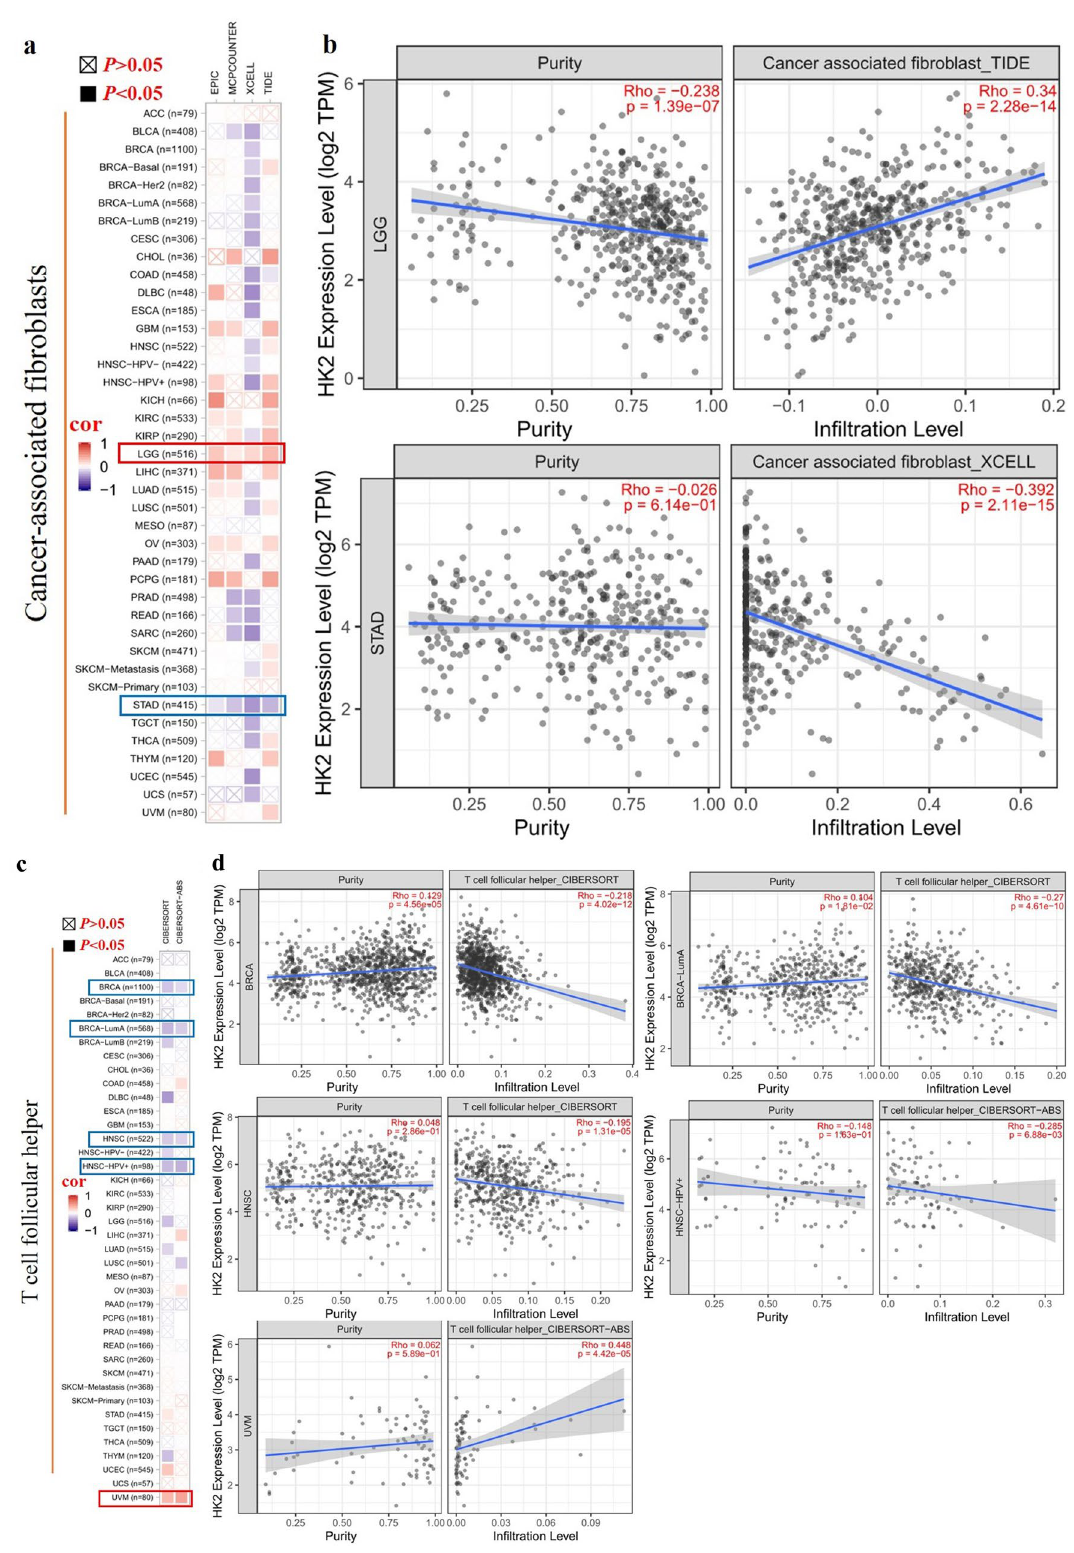
Figure 4. Correlation analysis between HK2 expression and immune infiltration of cancer-associated fibroblasts and T follicular helper cells. Different algorithms were used to explore the potential correlation between the expression level of the HK2 gene and the infiltration level of cancer-associated fibroblasts and T follicular helper cells across all types of cancer to